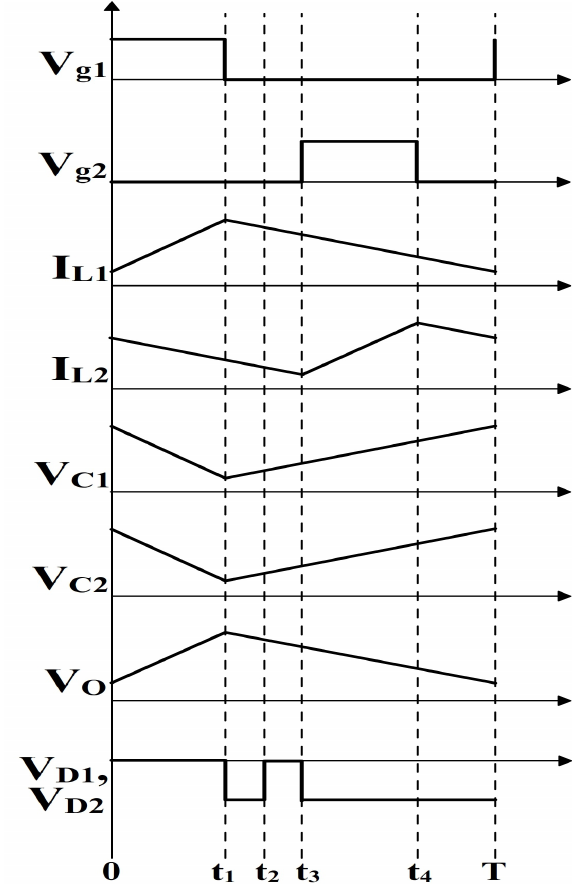
Figure 2. Characteristic waveforms of the proposed converter.